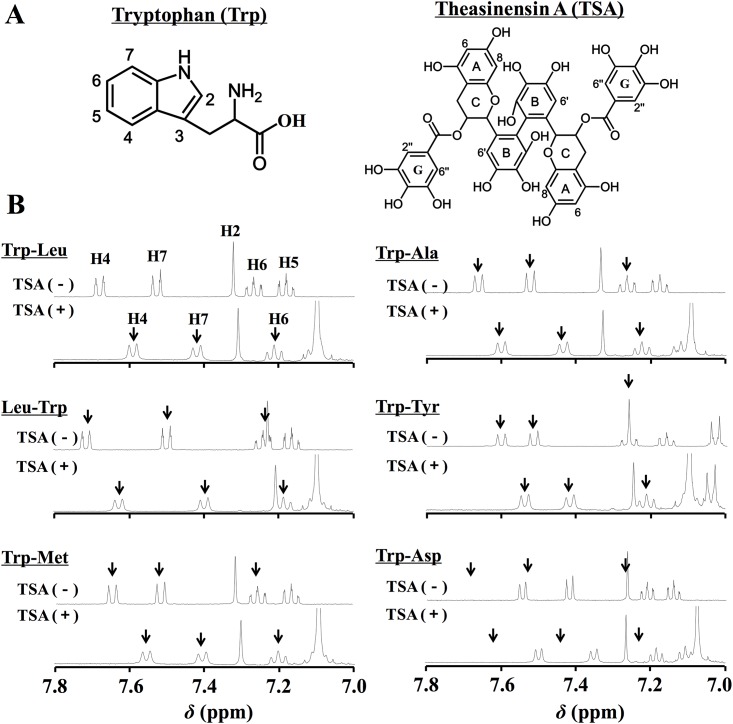
1H-NMR spectra of dipeptides in the absence or presence of TSA.(A) Chemical structures of Trp and TSA. (B) 1H-NMR spectra (7.0–8.0 ppm) of 3 mM dipeptides in the absence or presence of 9 mM TSA in D2O at 25°C. Target protons of each dipeptide with arrow were H7, H6, and H4. The overall views of each spectrum at 0–8 ppm are shown in S1 Fig.